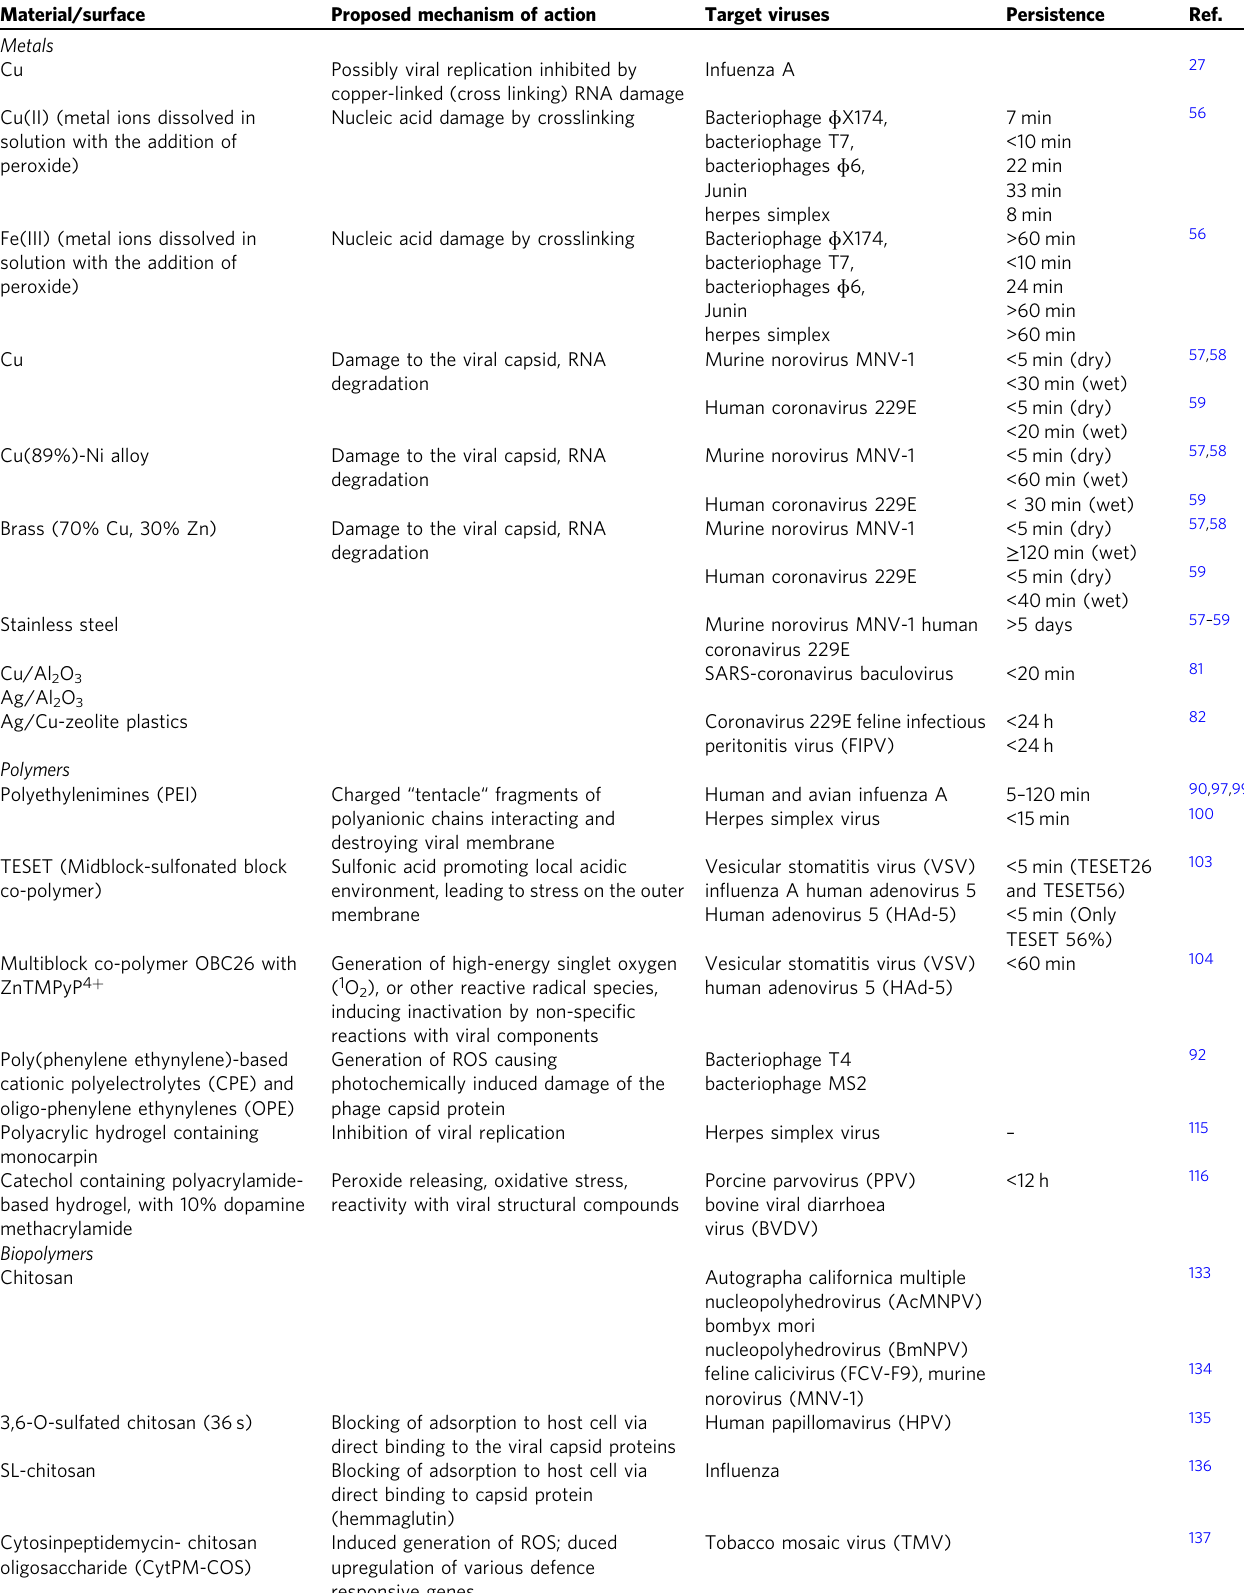
Table 3 Summary of literature on materials with antiviral properties with reported mechanism of action and